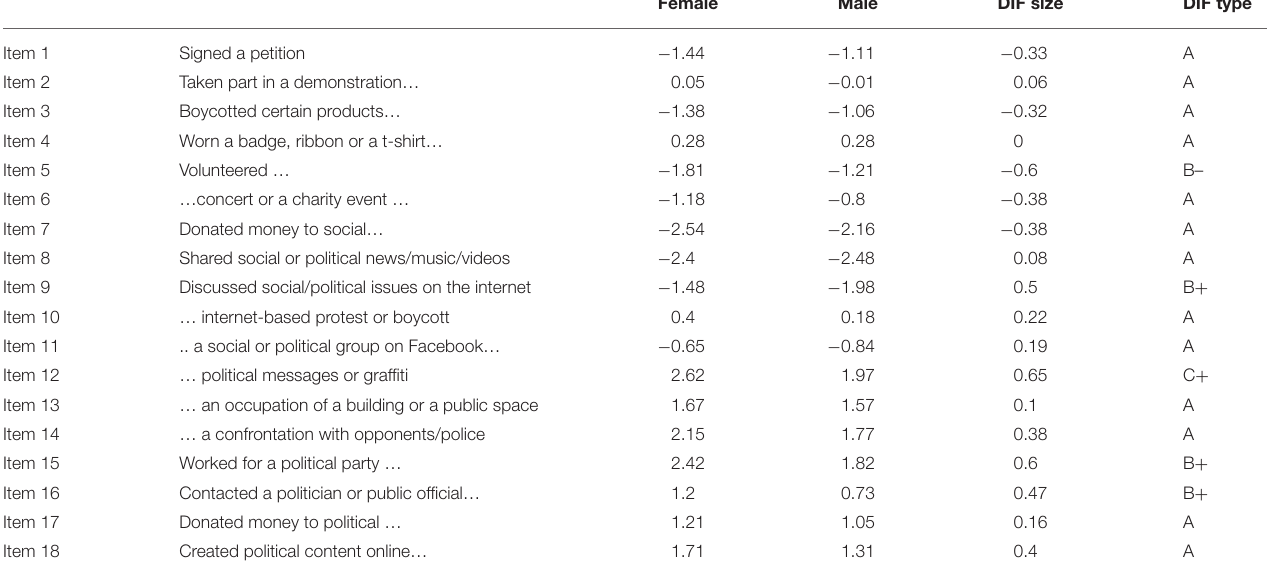
TABLE 7 | DIF based on